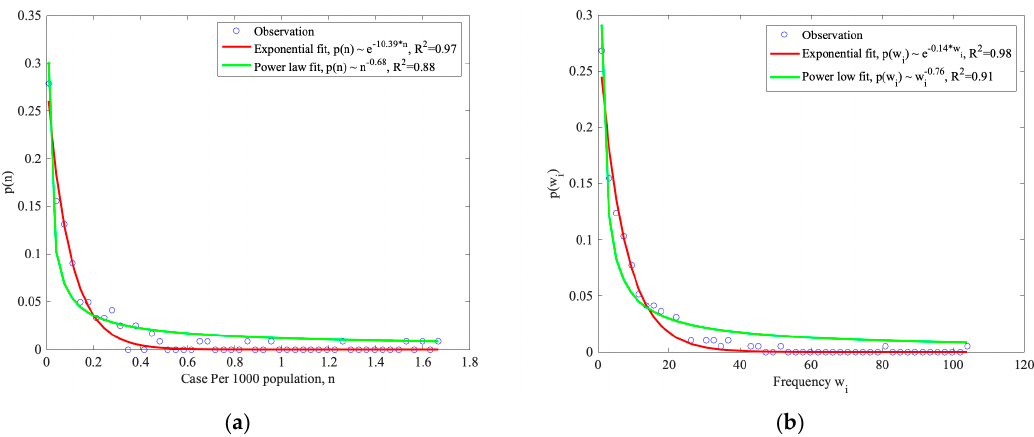
Figure 4. The frequency distribution of COVID-19 risk in Hong Kong: ( a ) The frequency distribution of R1; ( b ) The frequency distribution of R2.